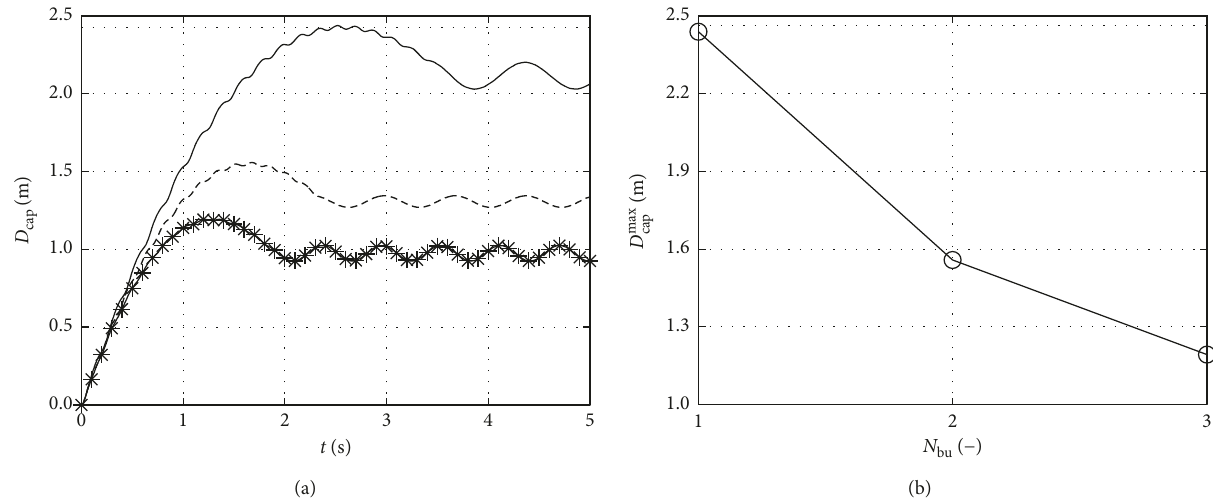
Figure 15: Time histories of cap displacement corresponding to different beam unit numbers (a) and maximum cap displacement D max versus beam unit number in one plane N bu (b).